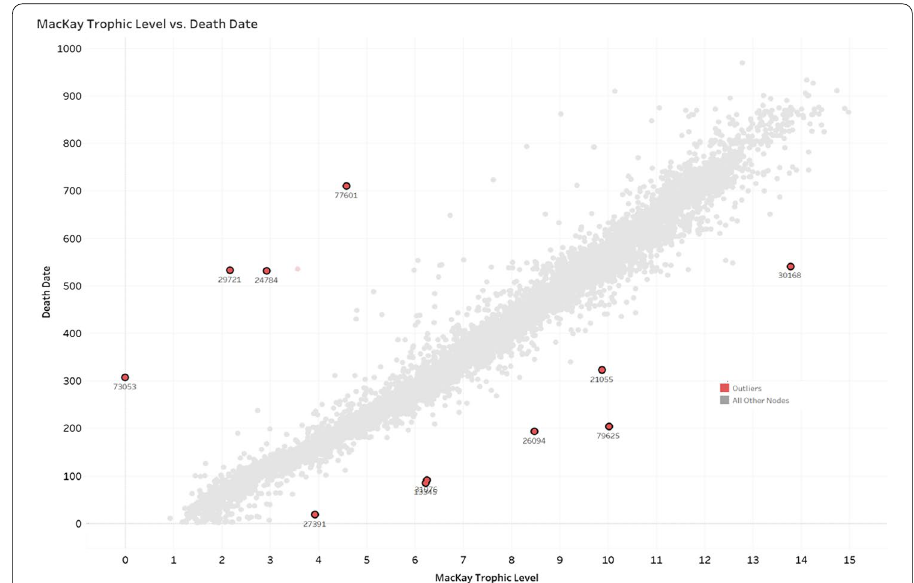
Fig. 8 Outliers Generalised trophic level against death date with some of the outliers